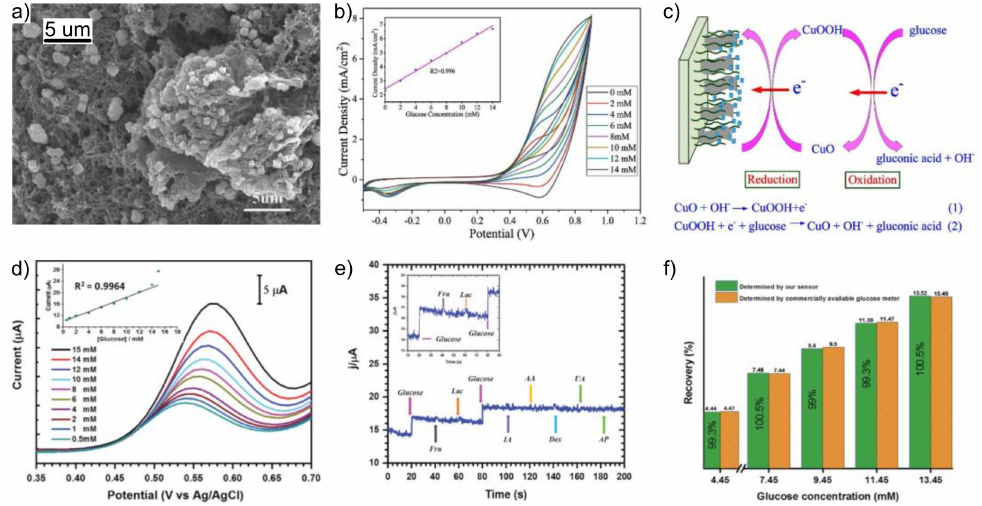
Figure 12. ( a ) SEM view of PAni/rGO/CuO NP sensor, ( b ) CV detection of glucose, ( c ) proposed sensing mechanism, ( d ) glucose detection with PANI(COOH)-PEI-Fc/Cu NP sensor using DPV and the obtained calibration curve, ( e ) selectivity of the device against common interferences, ( f ) performance against the commercial device. The figures were adapted with permissions from references Fang et al. [105] and Gopalan et al.